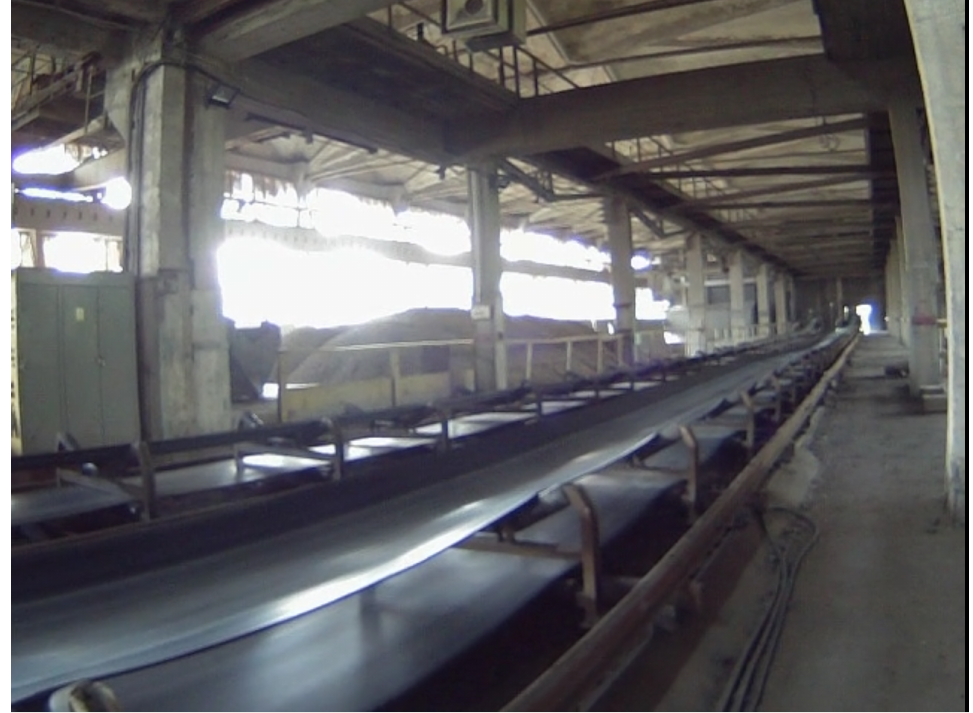
Figure 8. A general picture of the raw materials storage with belt conveyor to transport raw materials.